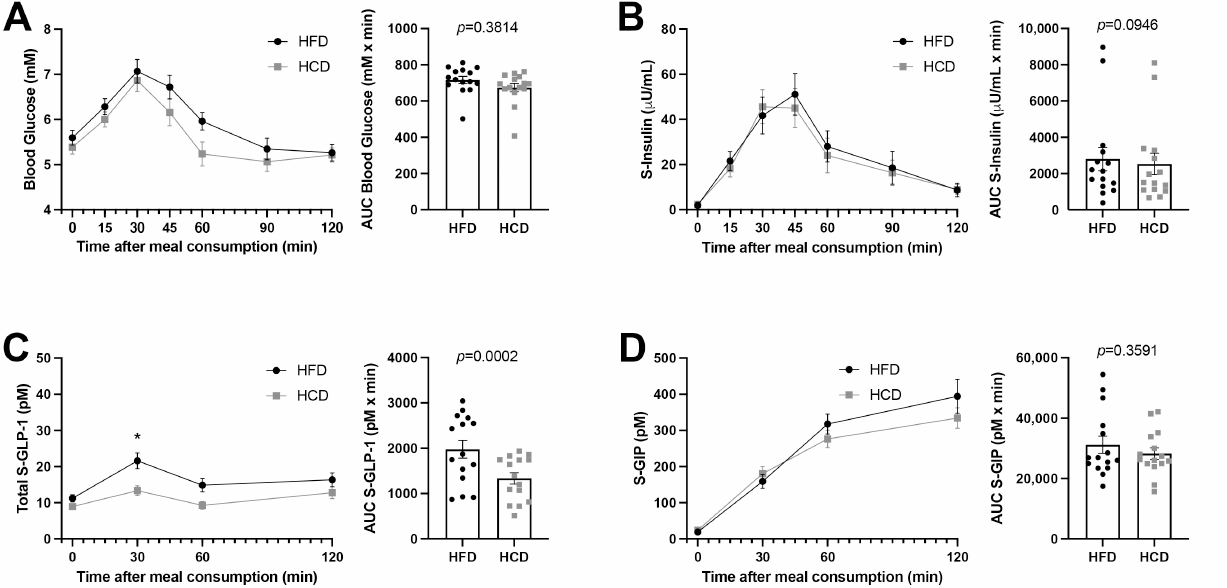
Figure 1. Glucose concentrations ( A ), insulin levels ( B ), GLP-1 ( C ) and GIP ( D ) in normal-weight, healthy subjects after two weeks of HFD (black circles) vs. HCD (gray squares) in a cross-over study design, 0–120 min after a mixed meal test (MMT). The MMT was ingested within the first 10 min starting at 0 min. * p < 0.05, using Sidak’s multiple comparisons test. The area under the curve (AUC), presented on the right in each panel, for each individual was calculated from the time profile and compared using the Wilcoxon